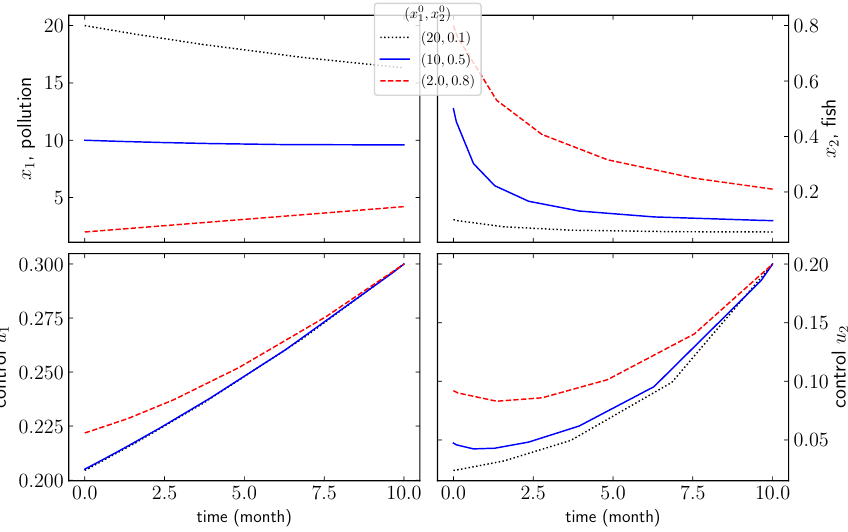
Figure 4. Dynamics of the state and control variables in the cooperative scenario for the terminal condition for the control p u